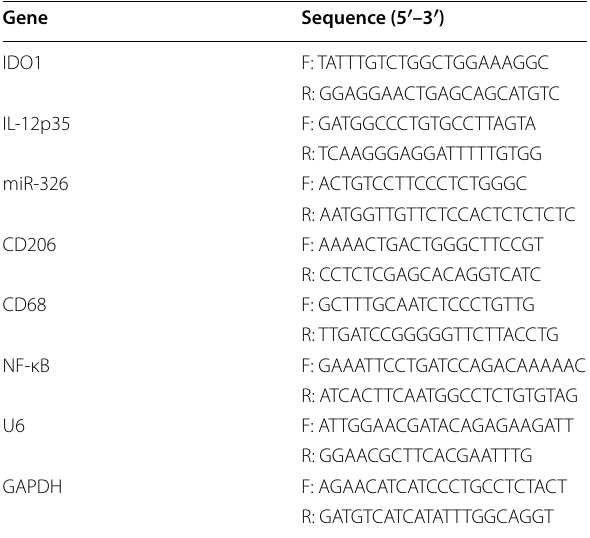
F, forward; R, reverse; IDO1, indoleamine 2,3-dioxygenase 1; IL-12p35, interleukin-12p35; miR-326, microRNA-326; NF-κB, nuclear factor κB; GAPDH, glyceraldehyde phosphate dehydrogenase